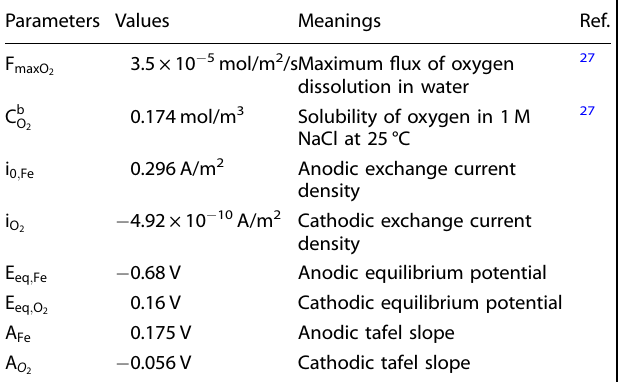
Table 2. Parameters used in the present